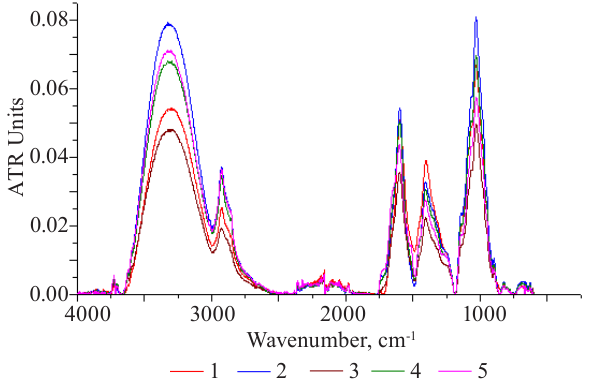
Figure 3 IR-spectra of dry extracts of industrial flax seeds according to extraction time: (1) 5 min, (2) 10 min, (3) 15 min, (4) 20 min, (5) 25